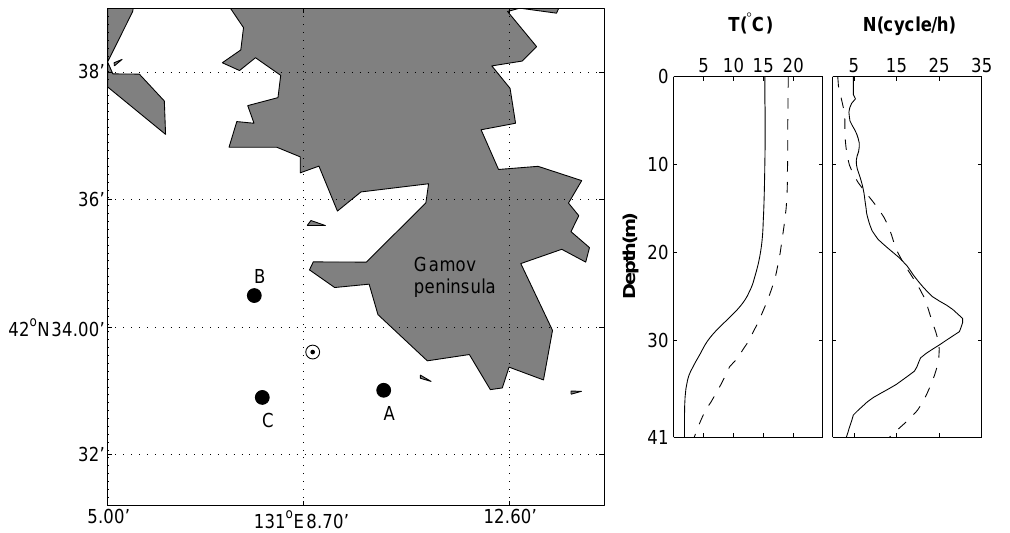
Fig. 1. (Left panel) Study area on the shelf of the Japan/East Sea in 1999, 2004 and 2012. The A and B mooring locations in September 2004 are shown, and the A, B and C mooring locations in September 2012 are shown. The circle indicates the location of the mooring vessel from which hourly casts were conducted in the autumn of 1999, 2004 and 2012. (Right panel) The vertical profiles of the background temperature T and buoyancy frequency N are shown in September 2004 (dashed line) and 2012 (solid